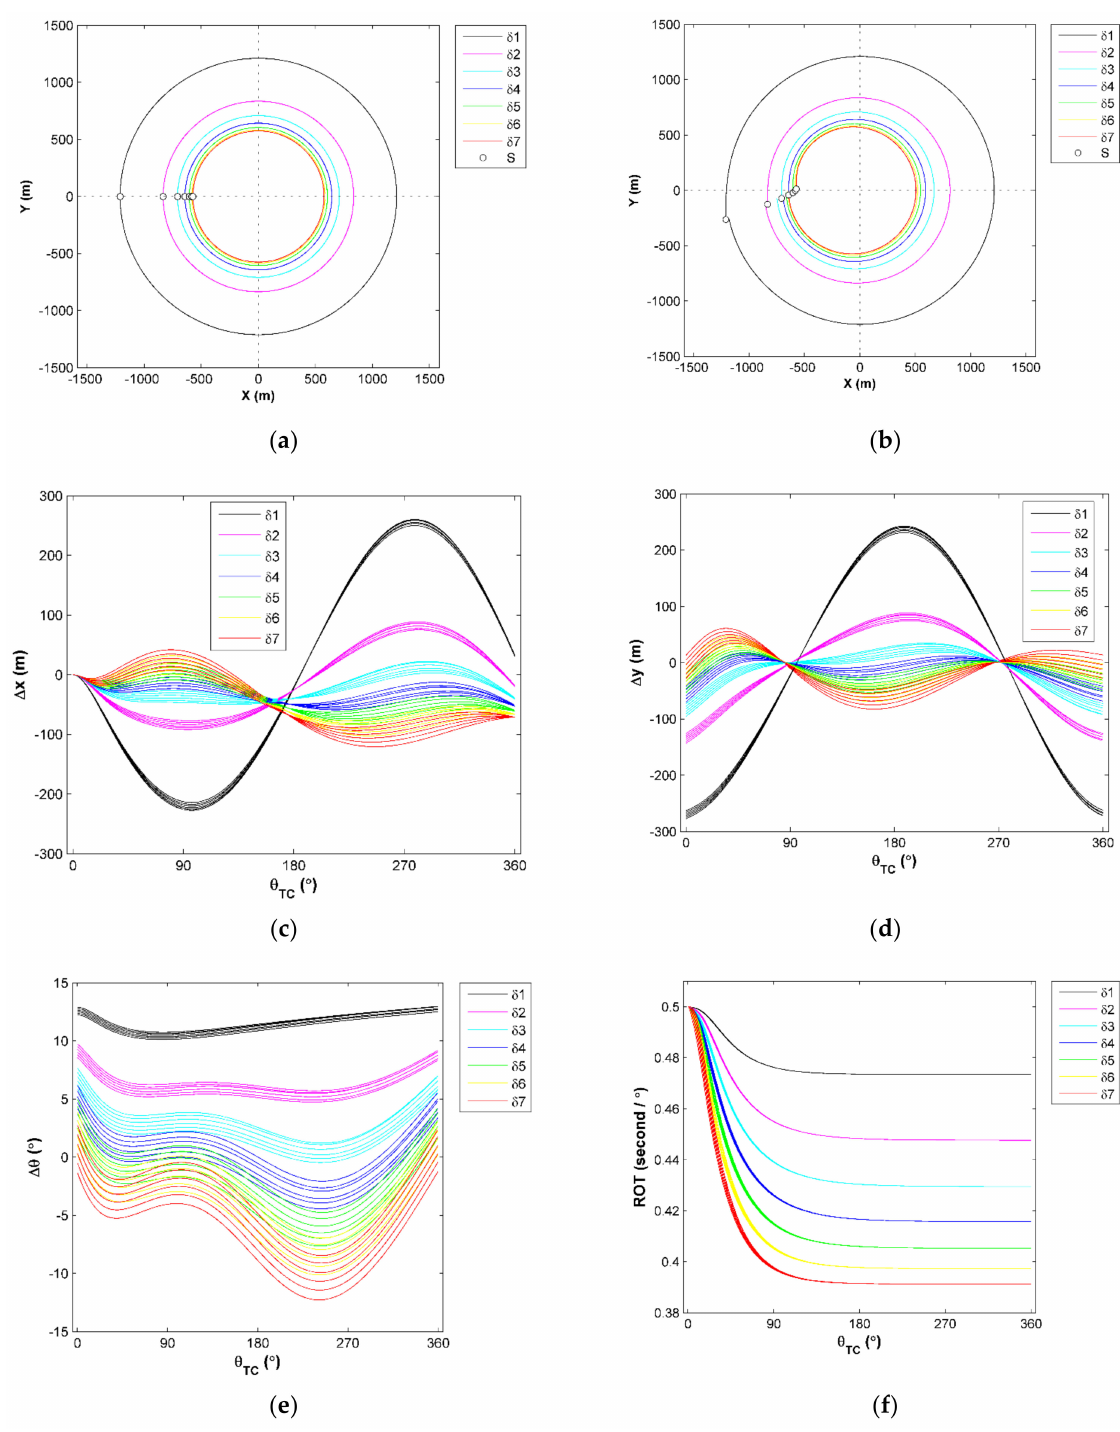
Figure 8. OS trajectory data processing results for calculating turning time ratios: ( a ) turning circles with radius R; ( b ) trajectory shifted to the coordinate center (0,0); ( c ) x -axis scale differences between turning circles and trajectories; ( d ) y -axis scale differences between turning circles and trajectories; ( e ) turning angle differences between turning circles and trajectories; ( f ) turning time ratio